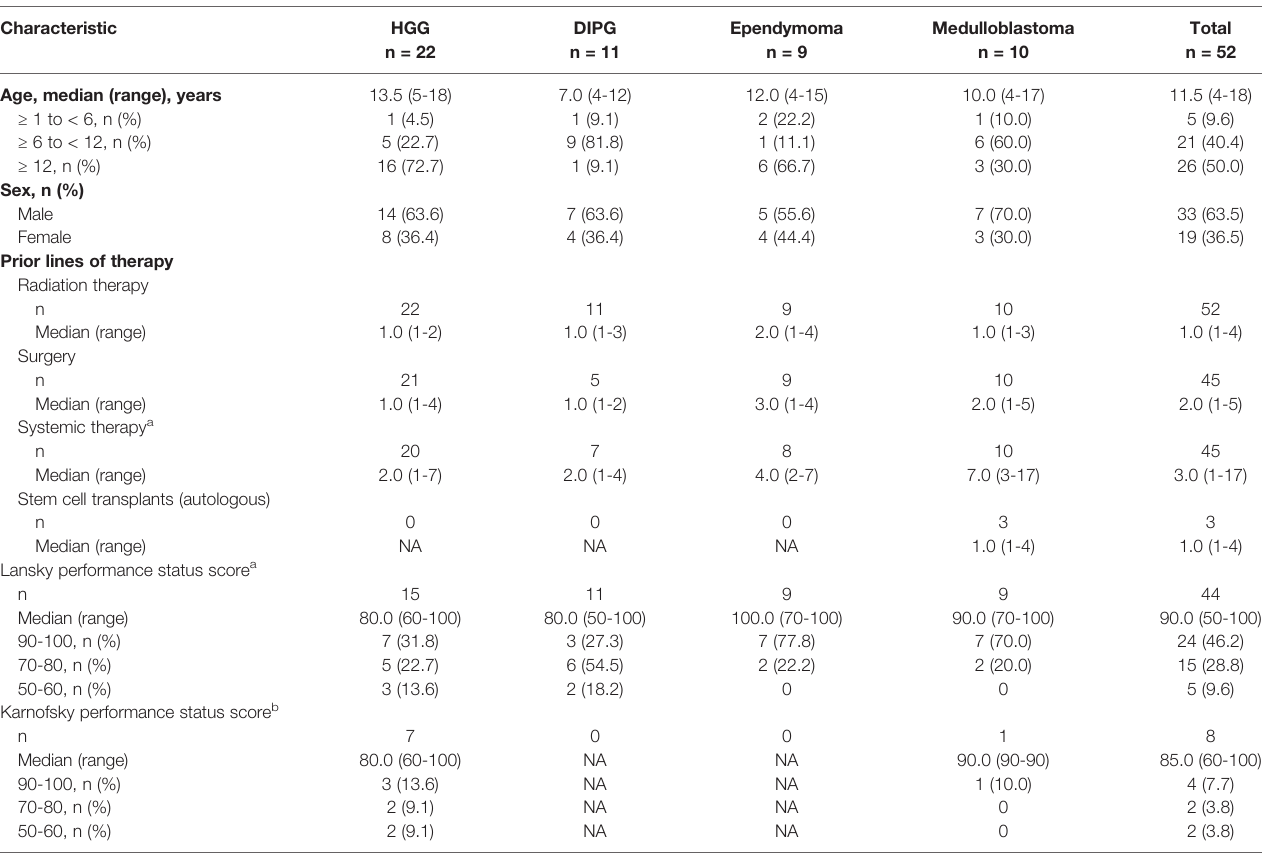
TABLE 1 | Demographics and Baseline Characteristics (safety